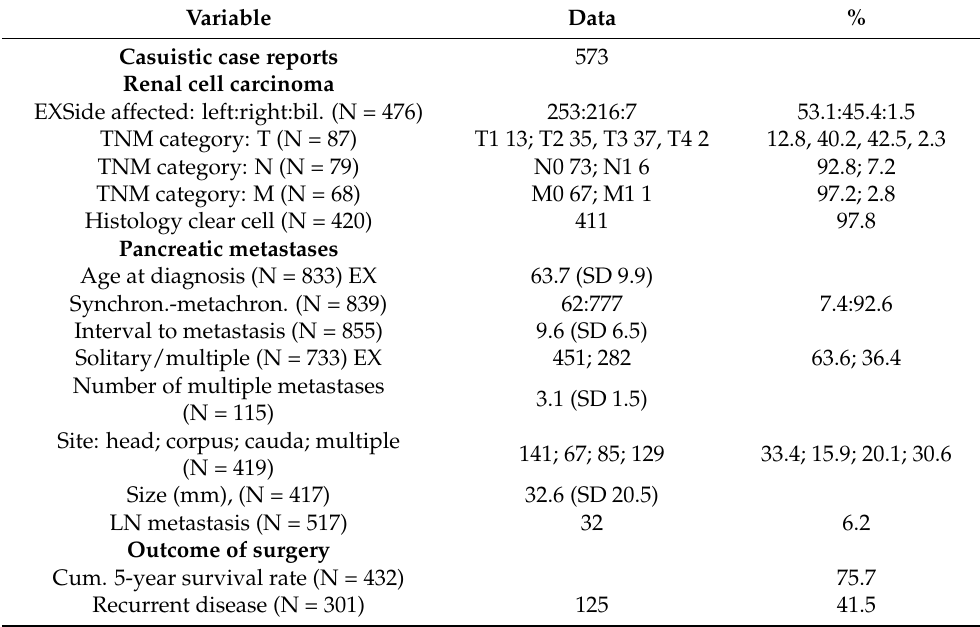
Table 1. Analysis of 1433 isolated pancreatic metastases from RCC (N = number of cases with adequate